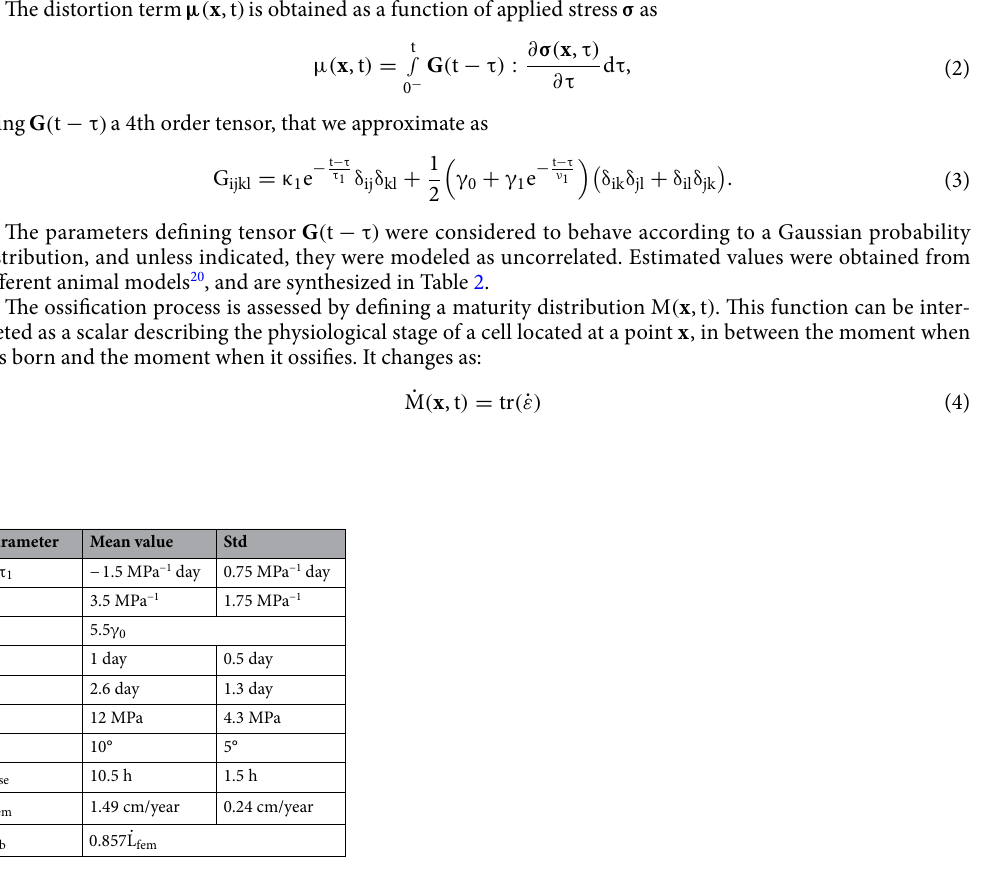
Table 2. Growth model parameters values. Unless indicated, parameters were considered to be non correlated, and behaving according to a Gaussian probability distribution.